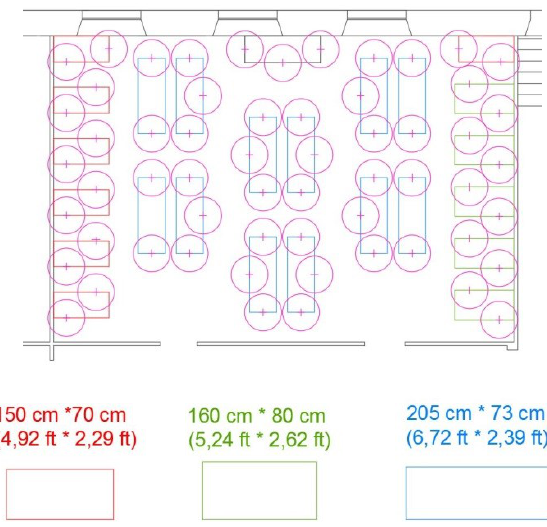
Figure 10. Table arrangement in the school canteen according to social distancing